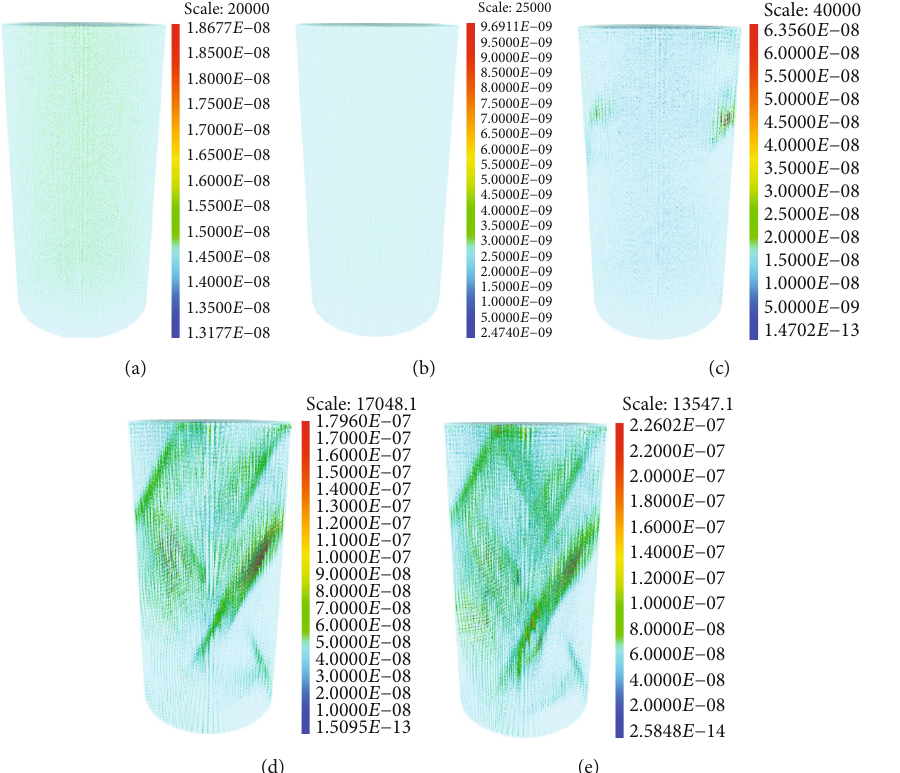
Figure 15: Evolution of discharge vectors (m/s) for simulated HM coupled test: (a) initial compressed stage, (b) elastic stage, (c) peak stress point, (d) stress drop stage, and (e) residual